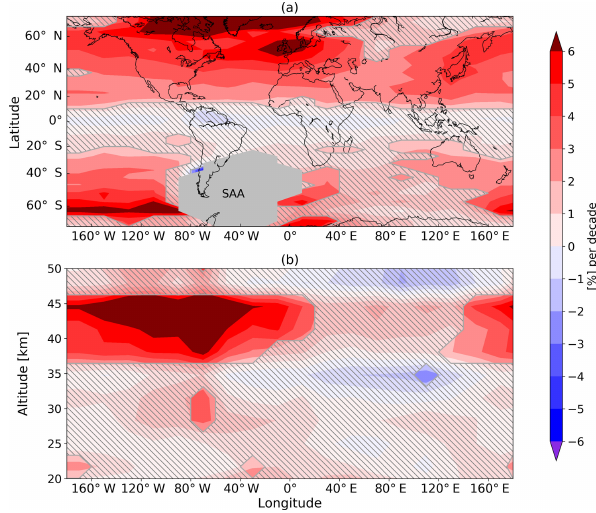
Figure 8. (a) Longitudinally resolved ozone trends at 41.3km in % per decade, computed over the 2003–2018 period from the SCIAMACHY/OMPS-LP anomalies’ merged data. Dashed areas indicate non-significant trends and the gray polygon labeled “SAA” indicates the location of the South Atlantic Anomaly. In panel (b) , the cross section of the longitudinally resolved trends is at 60 ◦